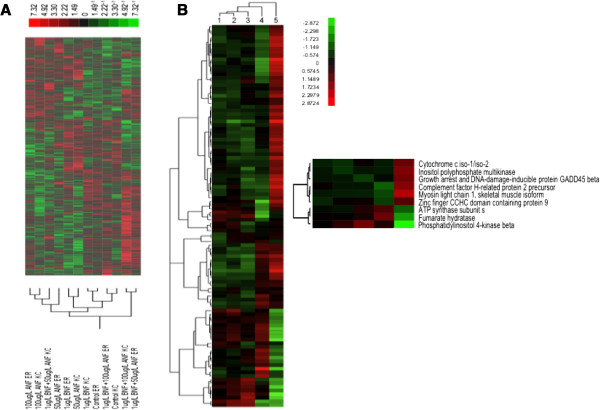
Gene expression of reference and resistant embryos exposed to PAH-surrogate chemicals. A) Heat map of significant genes reflecting all pairwise comparisons (p < 0.01) between reference and resistant embryos. Hierarchical clustering of the treatments (gene tree) is shown on the bottom of the heat map. Red indicates relative high expression levels and green represents low expression levels. B) Expression of 105 genes differs significantly (Mixed model ANOVA, p < 0.01) due to the effect of embryo morphology among reference and resistant embryos. Genes are clustered based on morphology scores, shown across the top of the heat map. Embryo morphology score was based on a 1–5 scale, 1 representing no deformities, 2-mild, 3-moderate, 4-severe, and 5-extreme, respectively. Subset of genes differentially expressed among severely deformed embryos relative to other treatment groups is shown to the right of the heat map. Red indicates high expression levels and green represents low expression levels.